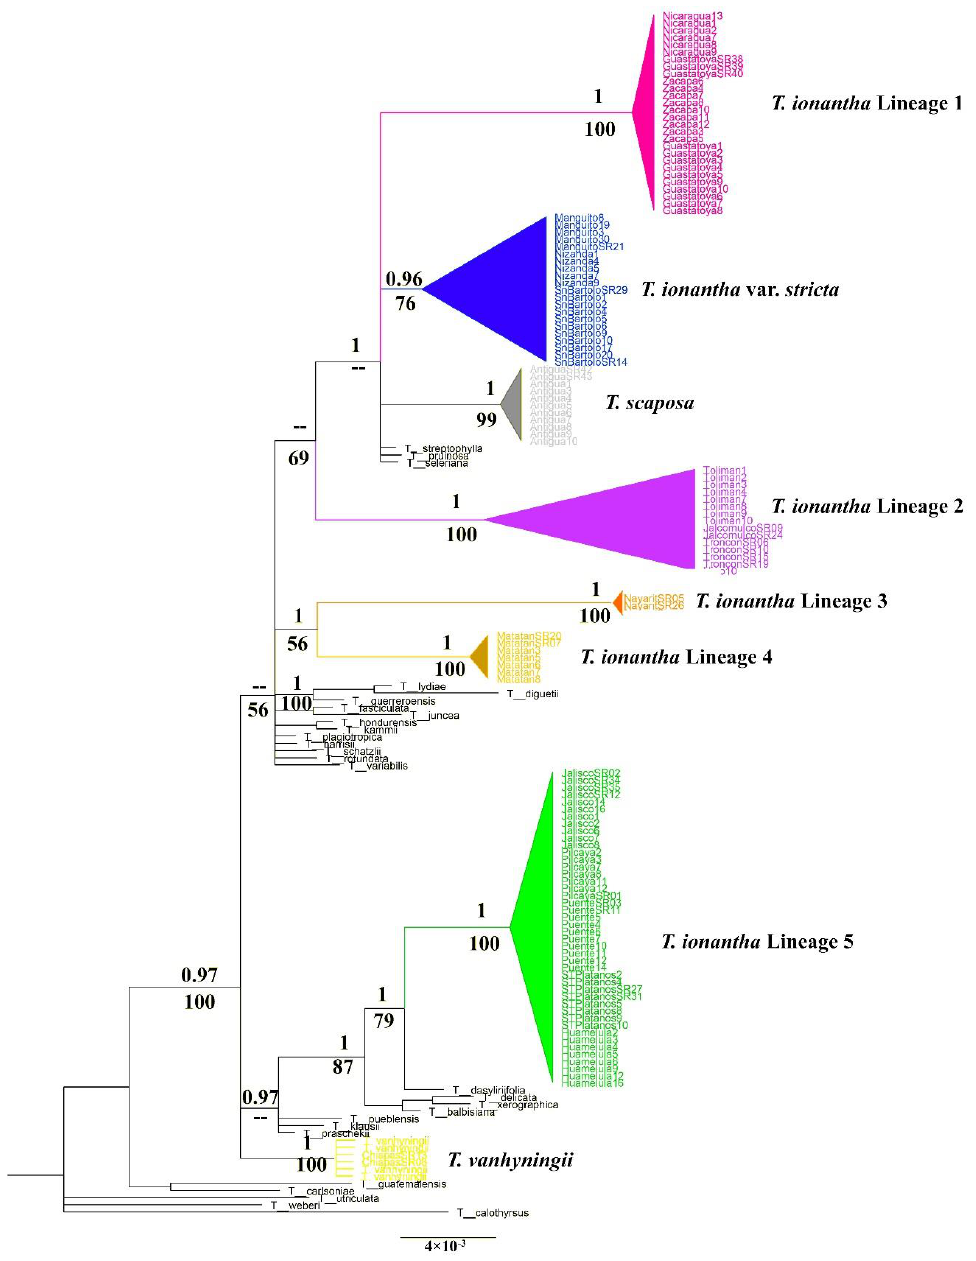
Figure 1. Phylogenetic tree estimated with Bayesian Inference using three cpDNA markers; PPB values ≥ 0.95 on the branches; Bootstrap values ≥ 50 below the branches. The collapsed and colored clades represent each of the eight lineages within the T. ionantha complex. Uncolored branch terminals (taxa) represent outgroup species.